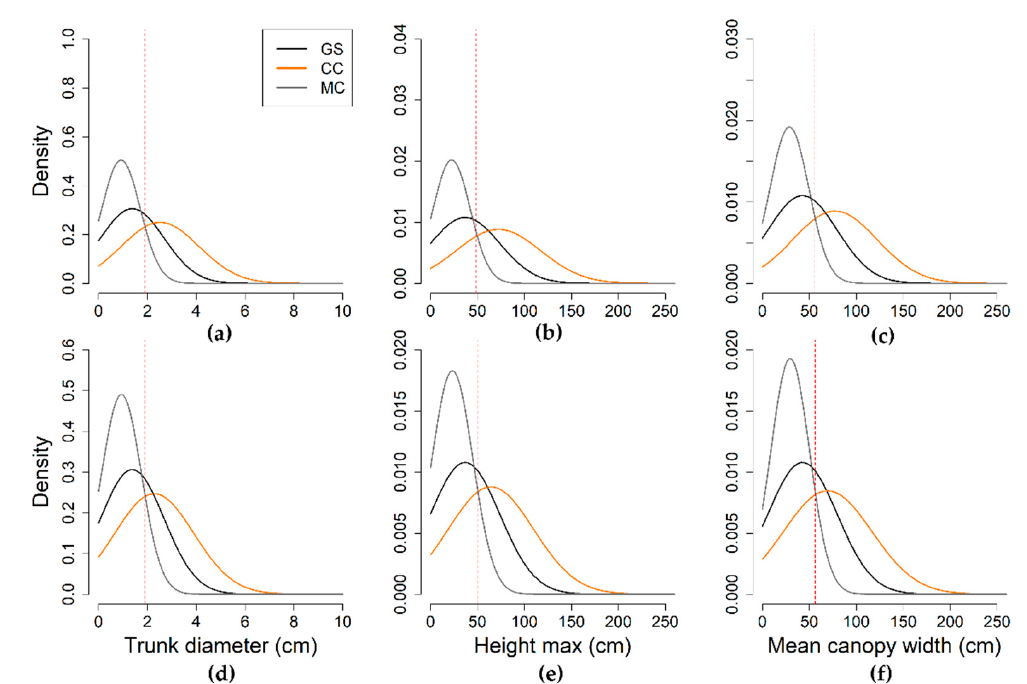
Figure 10. Density curve of the trunk diameter ( a , d ), maximum height ( b , e ) and mean canopy width ( c , f ) of the ground- surveyed larches (GS; solid black line), larches correctly classified (CC; solid orange line) and larches that were not detected and so misclassified (MC; solid grey line) through the semi-automatic classification methods. Density plots are reported for the most accurate pixel-based ( a – c ) and object-based ( d – f ) classification maps of the images acquired by drone in an abandoned subalpine grassland during mid-October 2018. The dashed red line marks the intersection between CC- and MC-larches density curves, whose x-value was set as the size threshold of the semi-automatic classification efficiency. Table 3. Land cover changes occurred in the study area from 2012 to 2018 as observed by the photo- interpretation (PI) of the LR images and by the most accurate pixel-based (PBC) and object-based (OBIA) classifications. Land cover change was determined through the identification of four cover classes: constant grassland (G) and constant shrubland (S), representing the area that maintained the same classification label (i.e., grassland or shrubland) from 2012 to 2018, and two more